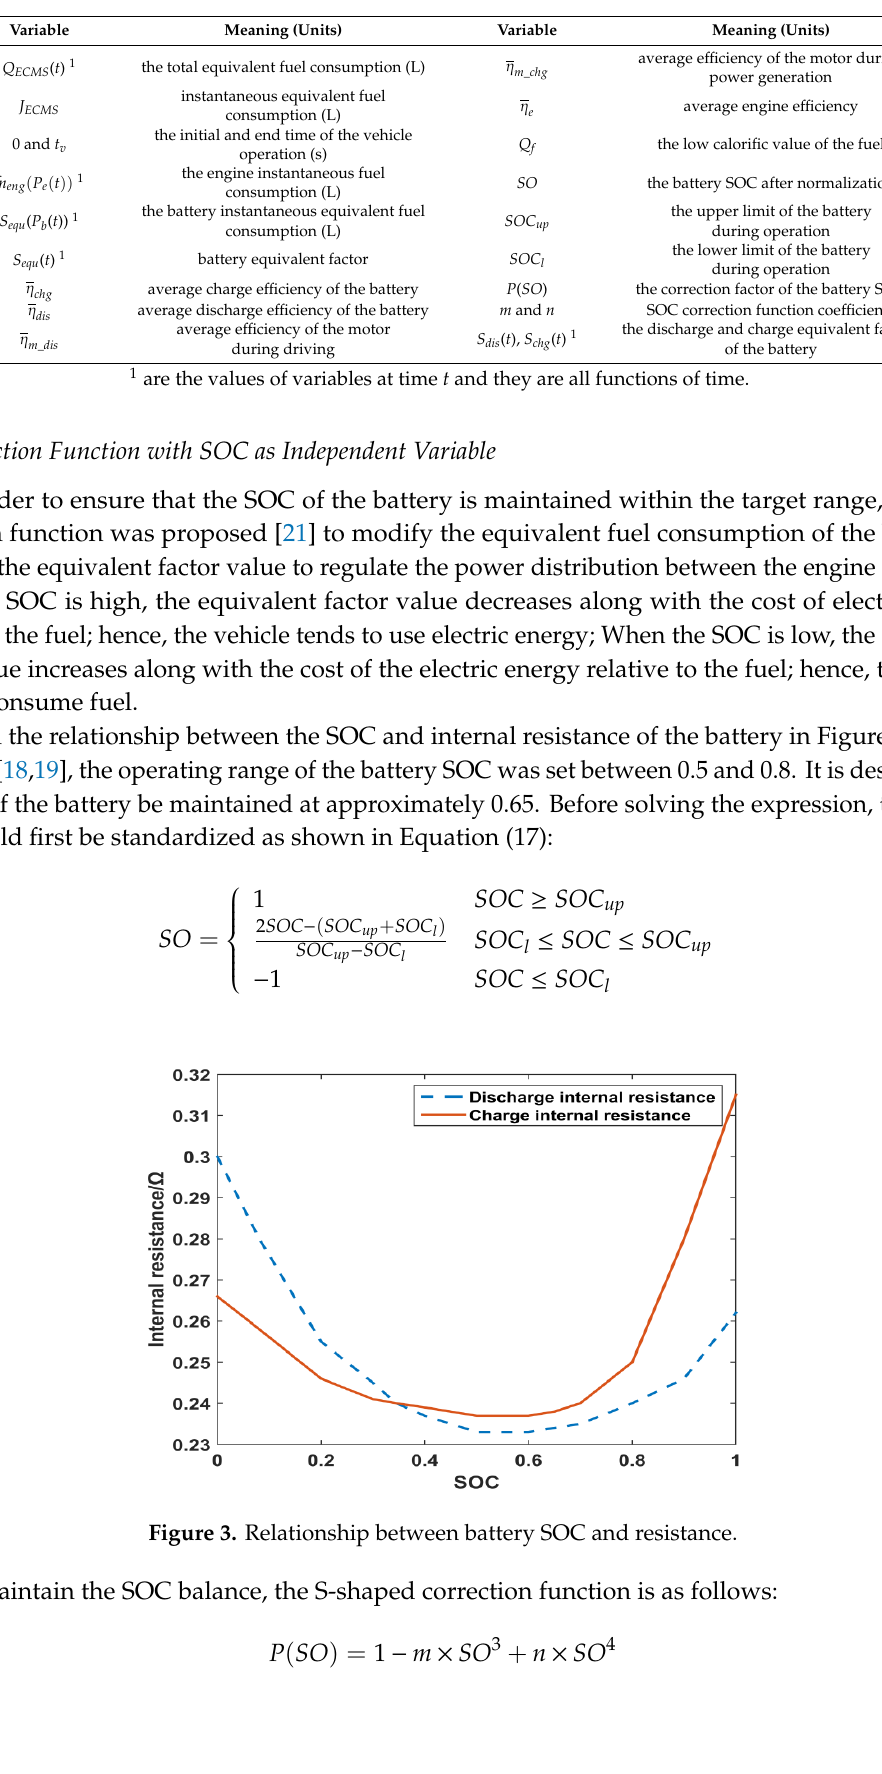
Figure 4. SOC correction function under different coefficients. 4. Improved ECMS Model 4.1. Correction Function with Acceleration a as the Independent Variable During the driving process, when the vehicle acceleration is large and the SOC of the battery is less than SOC low , the conventional ECMS control strategy will increase the value of the equivalent factor. At this time, the battery switches from the discharge state to the fast charge state, and the engine load is greatly increased, which in turn causes the engine operating point to deviate from the high-efficiency zone. Therefore, to reduce the engine fuel consumption rate when the vehicle acceleration is high and SOC is low, the equivalent factor should be appropriately reduced, and the torque output of the motor is increased to compensate for the increased external demand torque, thereby reducing the fuel consumption of the vehicle. From the driving conditions of the vehicle, the acceleration under four representative working conditions: NEDC, UDDS, HWFET, and US06 were selected for analysis. Figure 5 shows that the